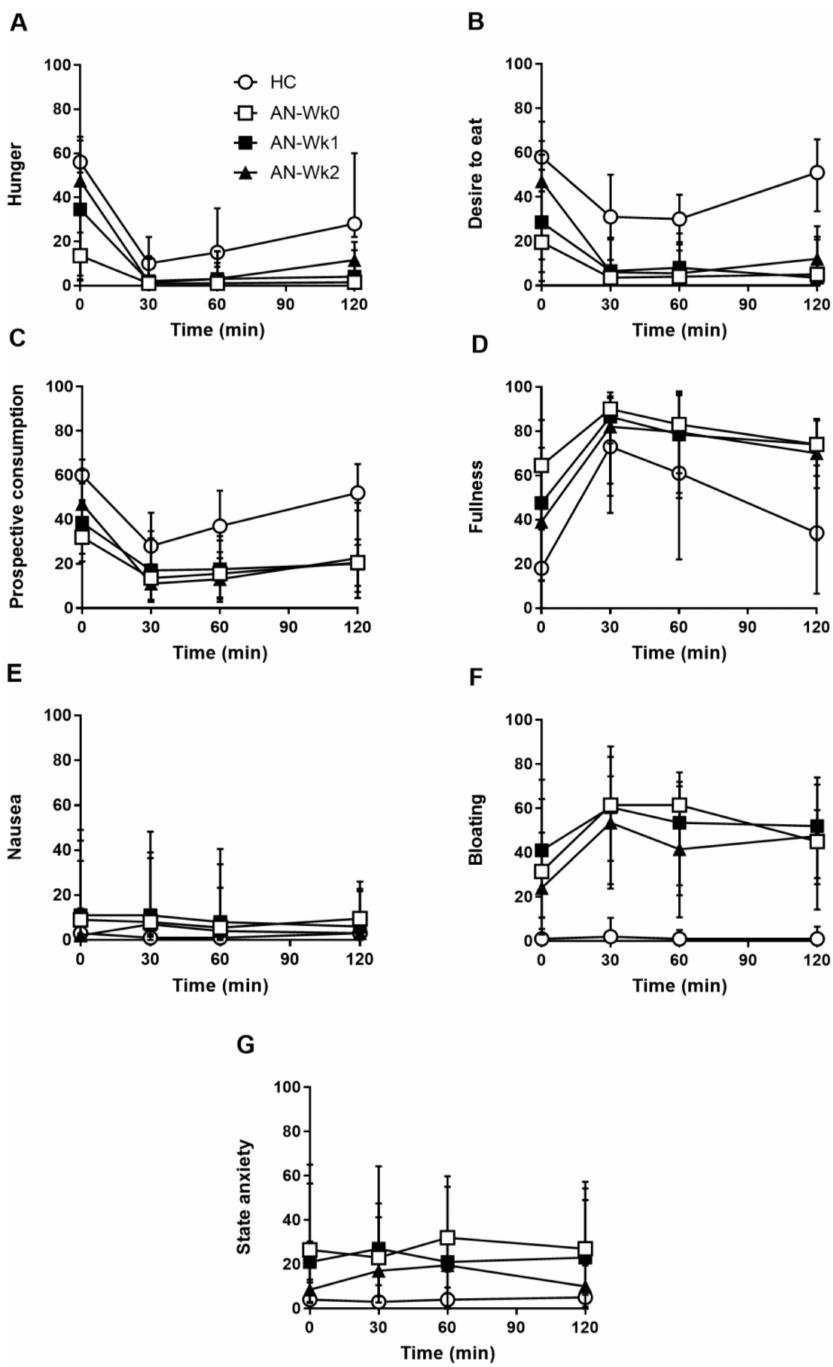
Figure 1. Hunger ( A ), desire to eat ( B ), prospective consumption ( C ), fullness ( D ) nausea ( E ), bloating ( F ) and state anxiety ( G ) scores before and after a mixed-nutrient, solid-liquid meal in 22 adolescent females with anorexia nervosa on admission (AN-Wk0), and after one (AN-Wk1) and two (AN-Wk2) weeks of refeeding, as well as in 17 age-matched healthy controls (HCs). Data are medians (25th–75th